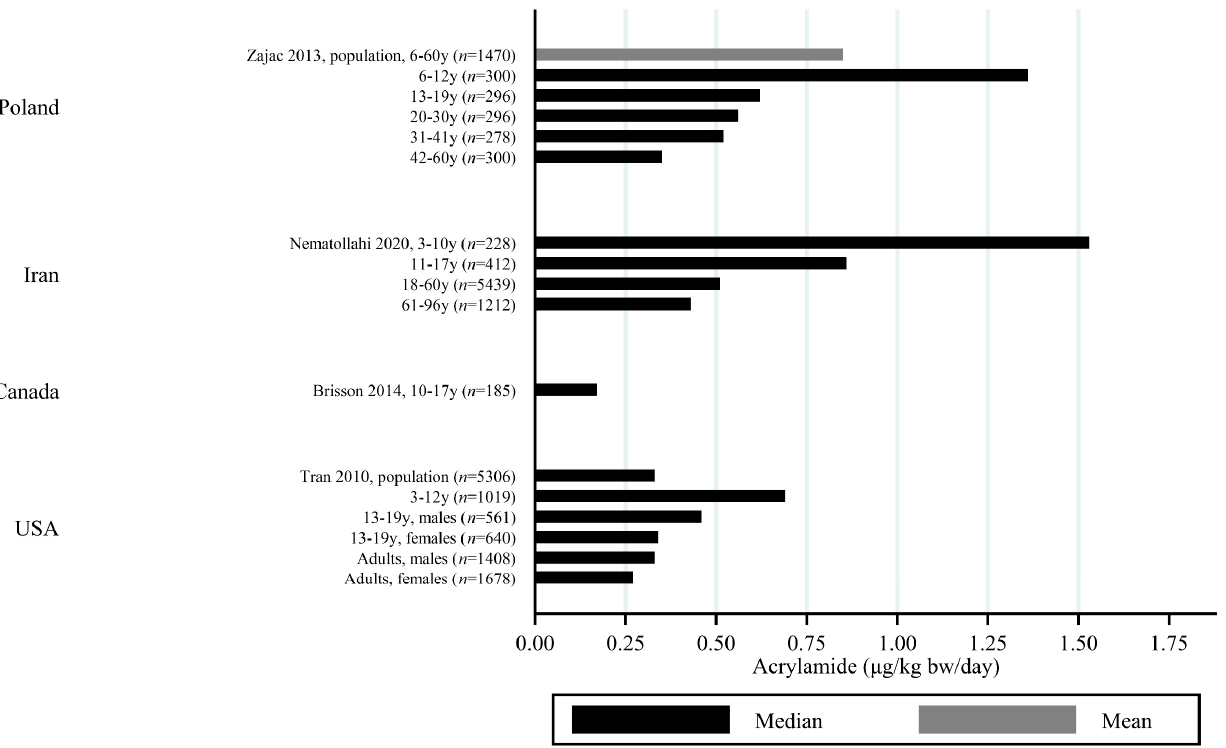
Figure 7. Median/mean estimated daily acrylamide intake per kg body weight ( µ g/kg bw/day), based on dietary questionnaire or both dietary questionnaire and dietary recall in studies including children by country.